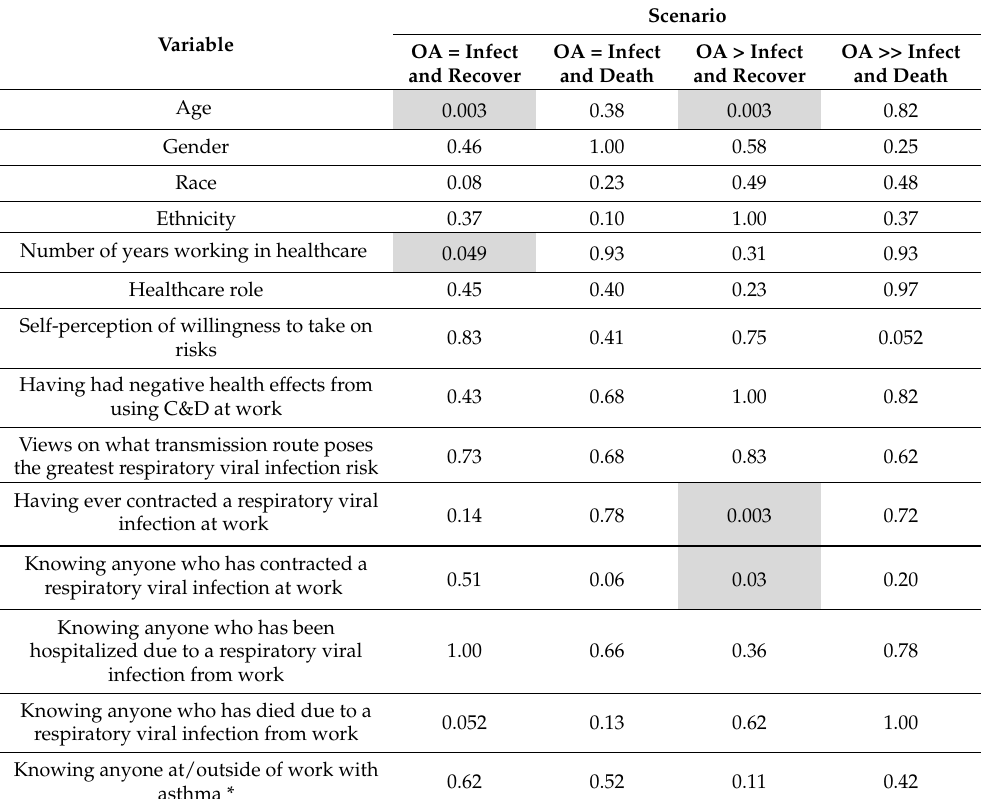
Table 4. Fisher’s exact test p -value results of associations between preference and demographic vari- ables, respiratory viral infection experiences, and asthma experiences. p -values < 0.05 are emphasized by cells that are shaded gray. Scenario Variable OA = Infect OA = Infect OA > Infect OA >> Infect and Recover and Death and Recover and Death Age 0.003 0.38 0.003 0.82 Gender 0.46